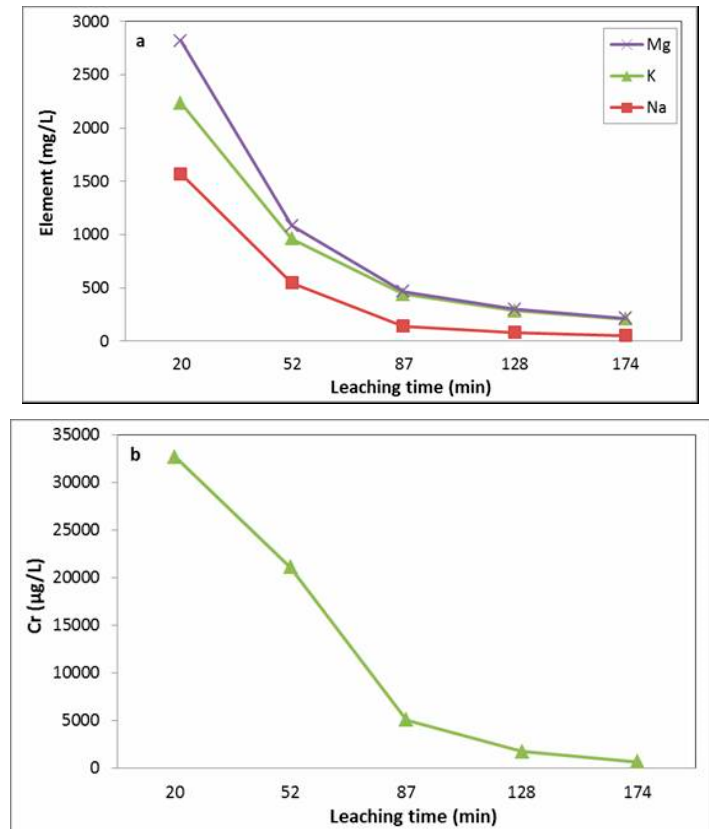
Figure 2. Variation of ( a ) alkali and ( b ) Cr concentration with leaching time from soil / unstabilized OK / MSW ash.